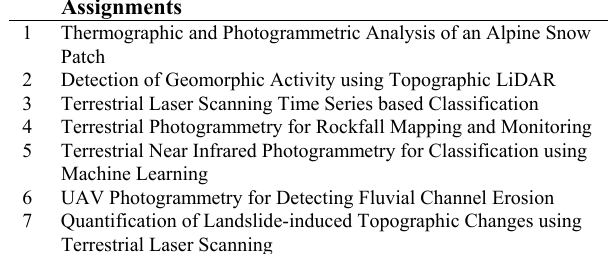
Table 2. Assignment topics Assignments 1 Thermographic and Photogrammetric Analysis of an Alpine Snow Patch 2